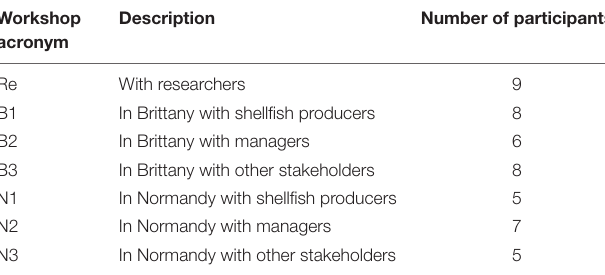
TABLE 1 | Characteristics of the seven